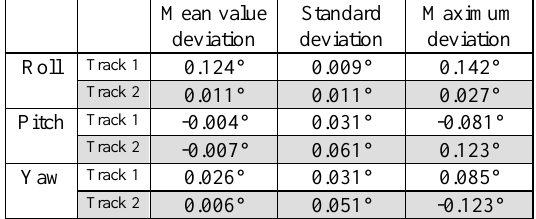
In Figure 4 measured and calculated relative pose angles are compared. Calculations were performed with a NCC model using a radius of 70 pixels and a correlation threshold of 0.9.